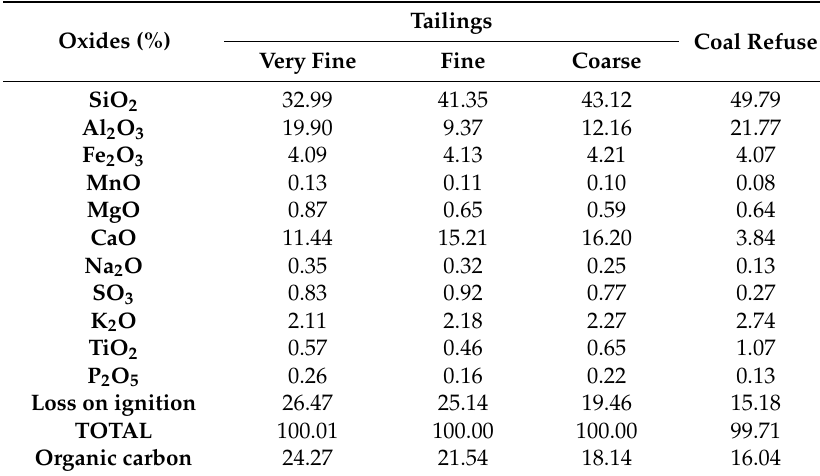
Table 5. Chemical analysis of the four raw tailings samples.